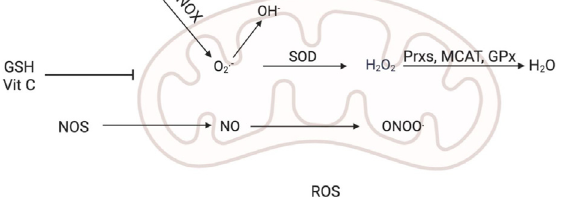
FIGURE 2 Generation and regulation of ROS. Superoxide (O 2 − ) is produced by incomplete reduction of molecular oxygen in the mitochondrial electron transport chain (ETC) or through NADPH oxidase (NOX)activity. In general, SOD disproportionates O 2 − to form H 2 O 2 , and peroxidase (Prxs) further reduces H 2 O 2 to water, catalase (CAT) or glutathione peroxidase (GPx). SOD can also be converted into OH − , and OH − is a more reactive and destructive ROS. NO is produced by three different NO synthases (NOSs).O 2 − reactswithNOtoproduceONOO − ,whichleadstothe formation of nitrotyrosine. Reduced glutathione (GSH) and ascorbic acid (vitamin C) can reduce ROS